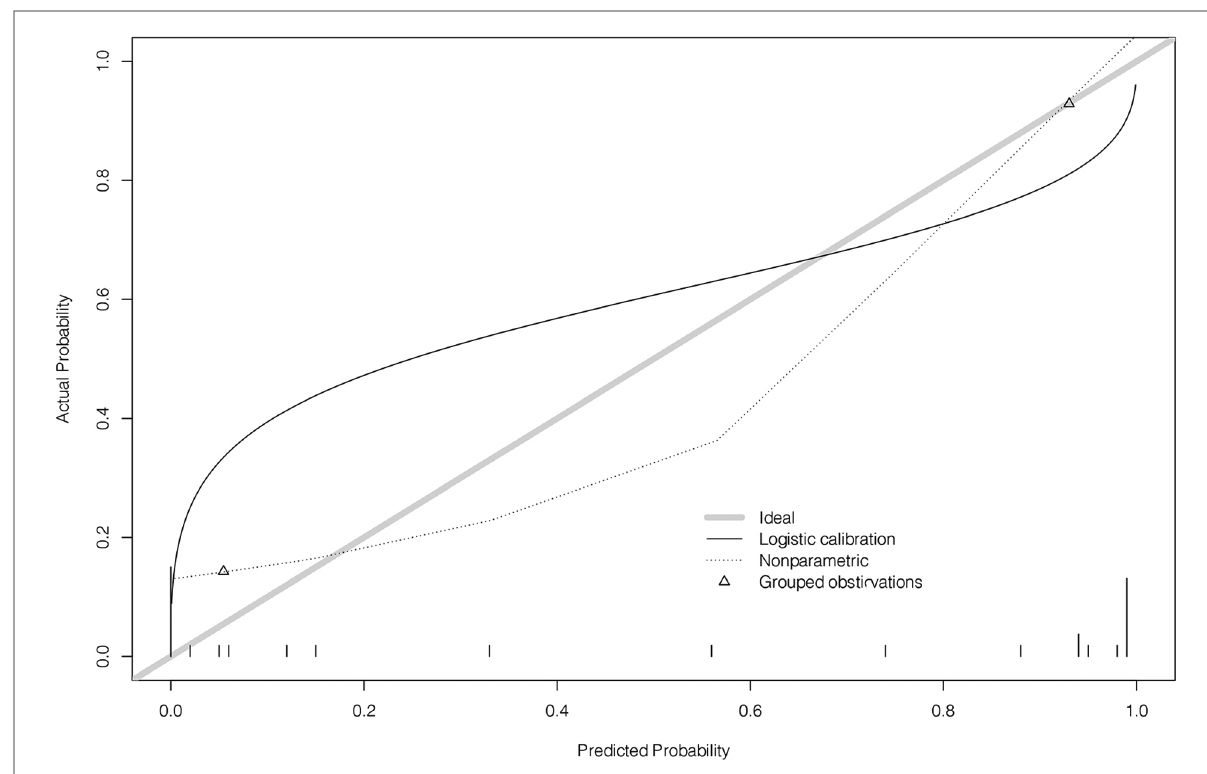
FIGURE 5 Prediction of cumulative effect. AL, axial length; WTW, white-to-white; K, keratometry.